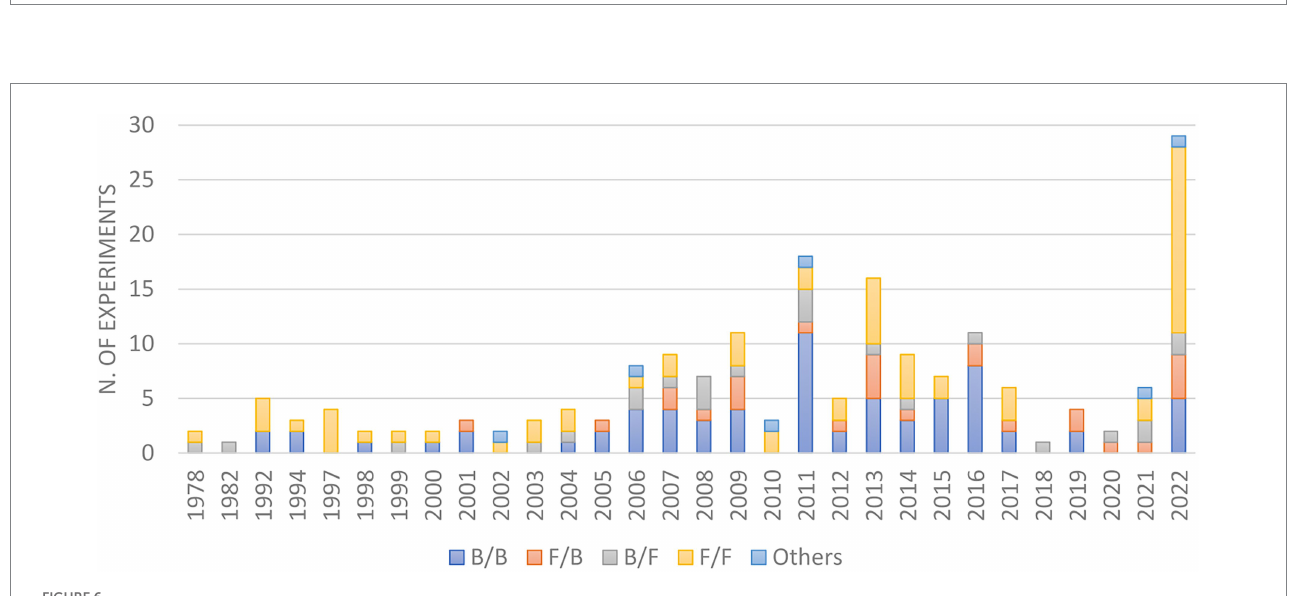
FIGURE 6 Microorganisms pairwise used in co-culture experiments since